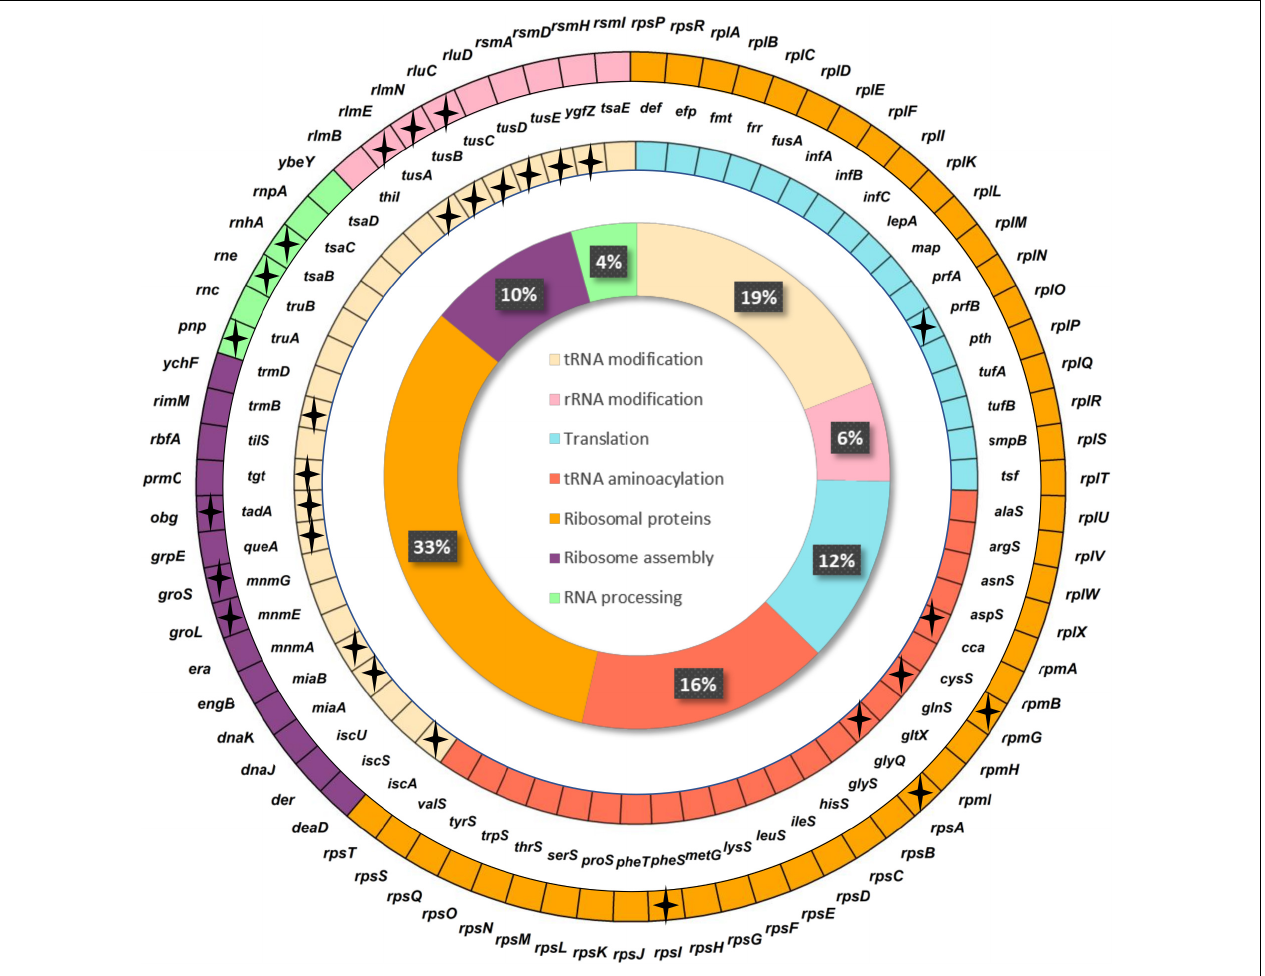
FIGURE 4 | Minimal translational machinery proposed in this work. Genes are classified by translational subfunction. Inner circle shows the percentage of genes in each subcategory based on hierarchical cluster analysis (HCA) analysis. Stars indicate genes not found in